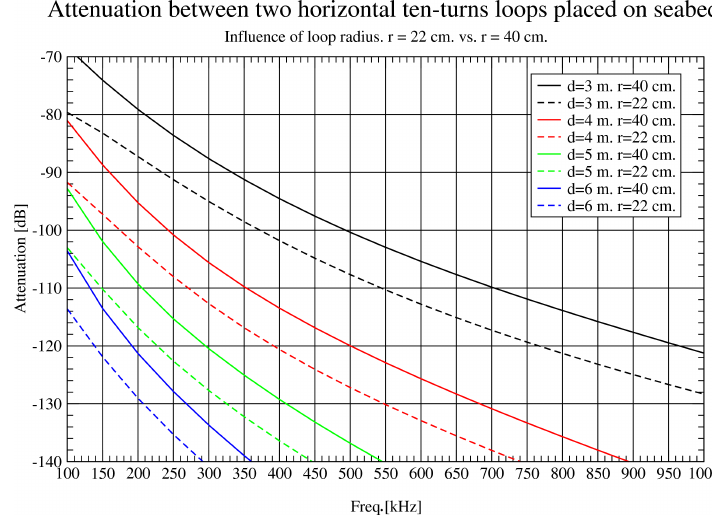
Figure 9. Influence of loop radius (100 KHz–1 MHz).